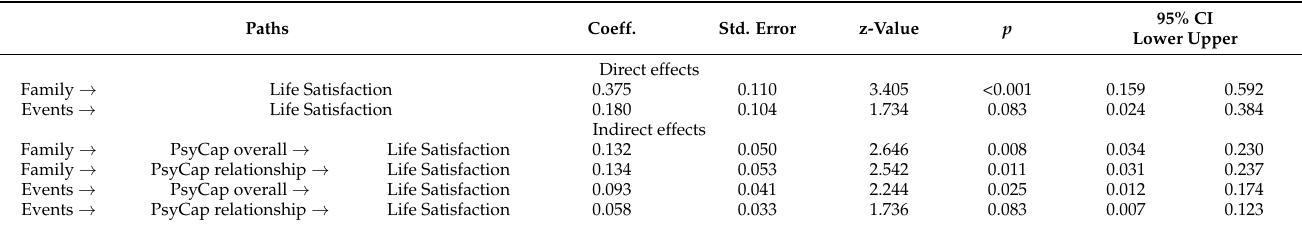
Table 14. Mediation analysis results in the total sample of respondents: the role of psychological capital as a